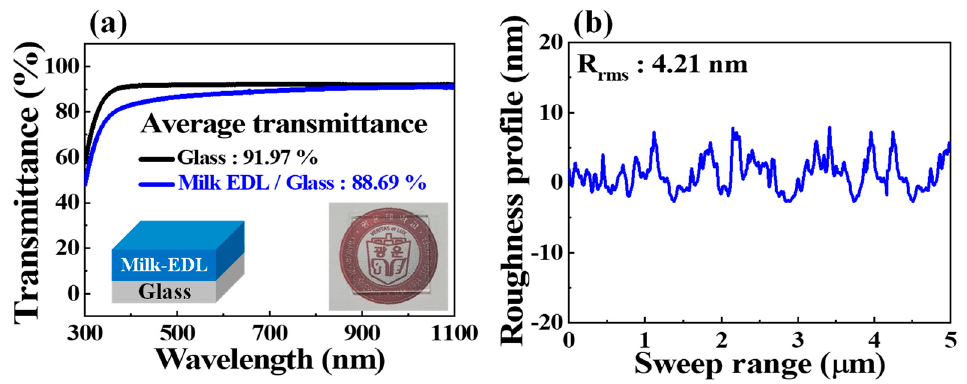
Figure 2. ( a ) FT-IR spectrum of the dried bovine milk-EDL membrane. ( b ) Frequency-dependent capacitance of ITO/milk-EDL/ITO-structured capacitors.